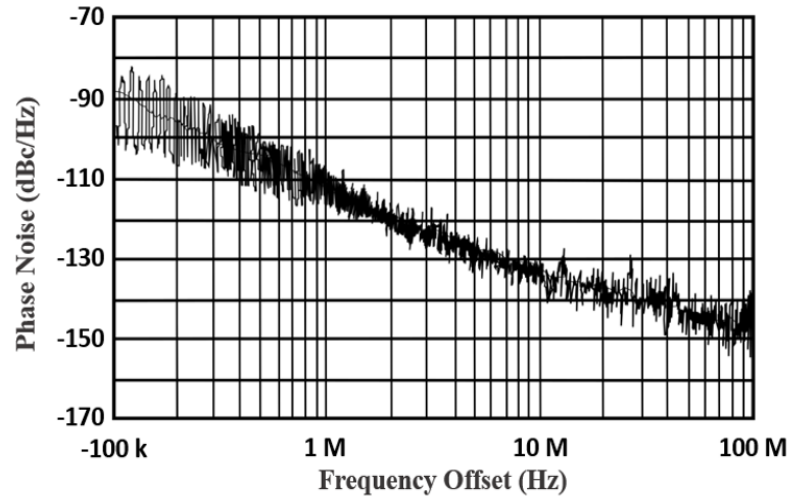
Figure 14. Measured phase noise of the